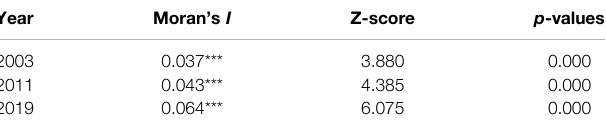
TABLE2| GlobalMoran ’ s I